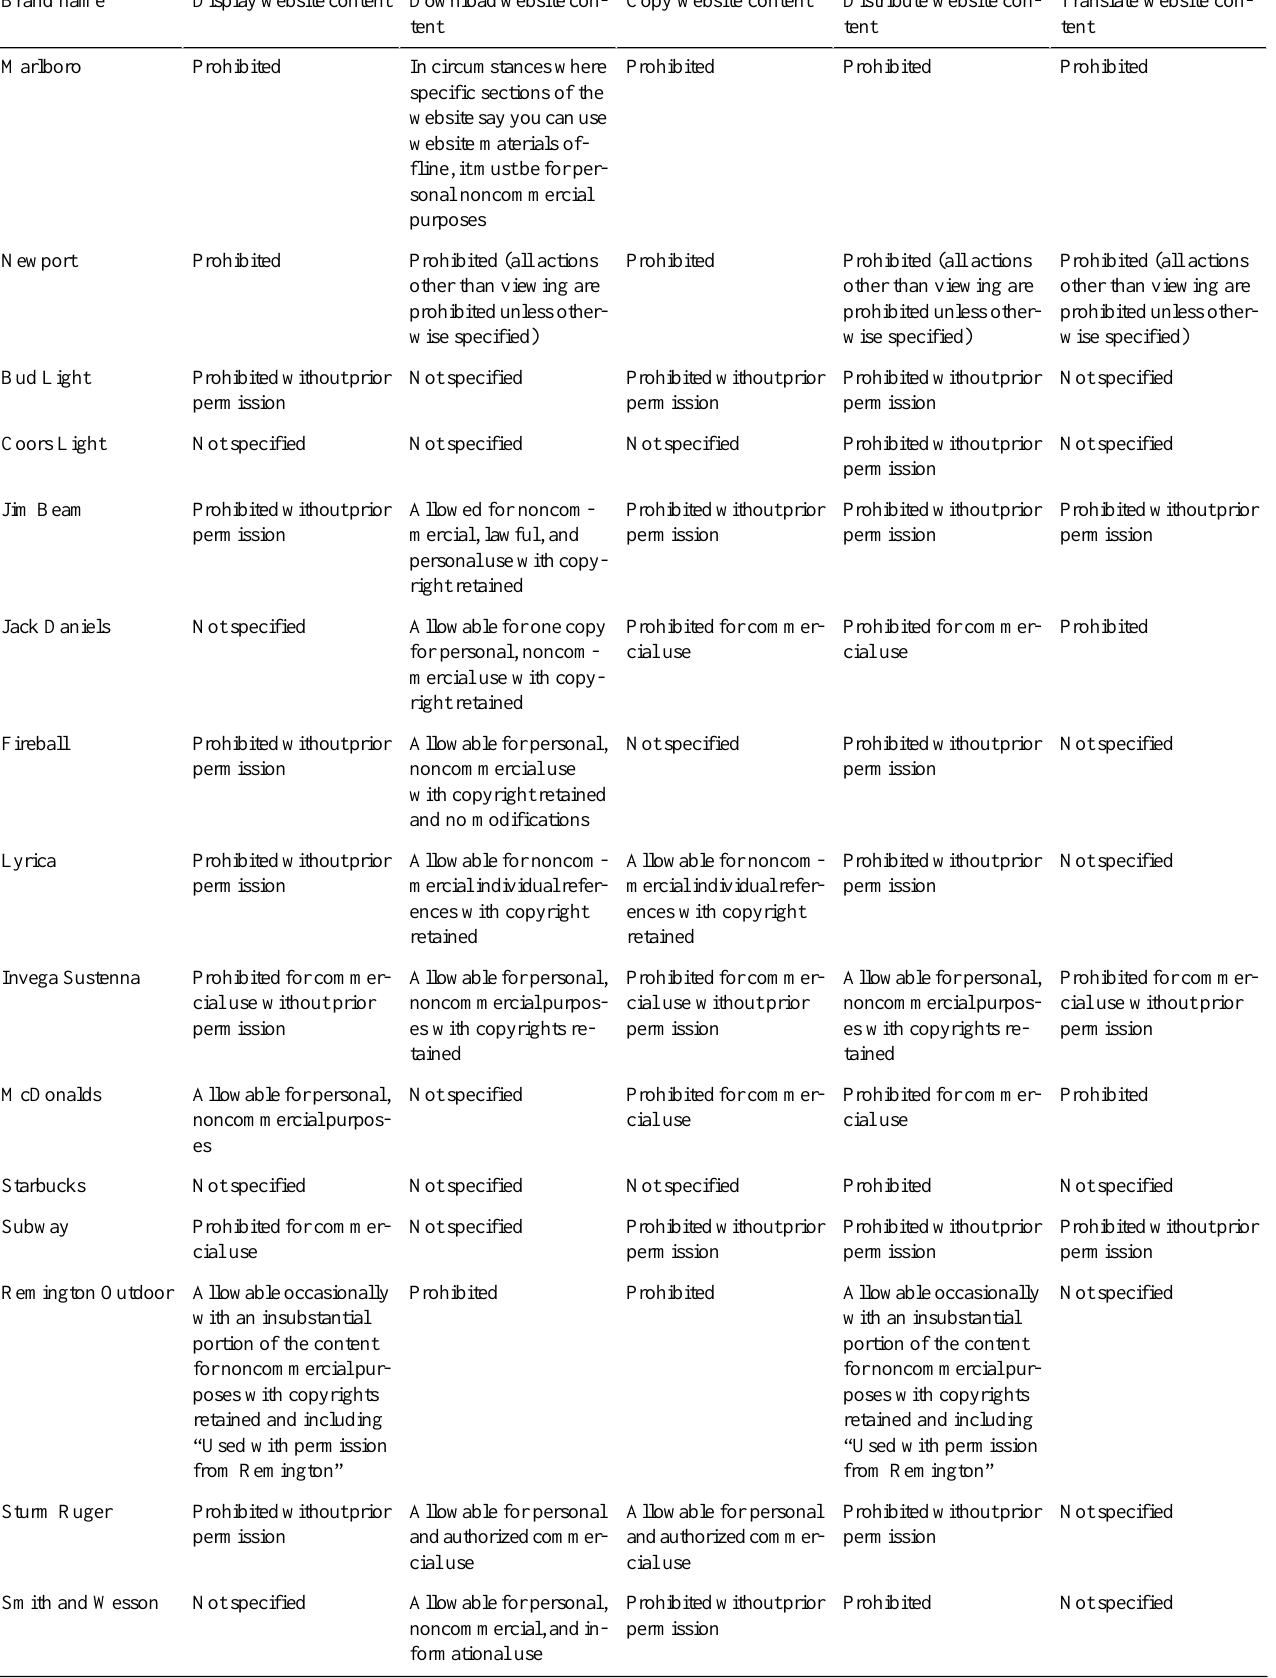
Table 4. Prohibited or allowable use of website